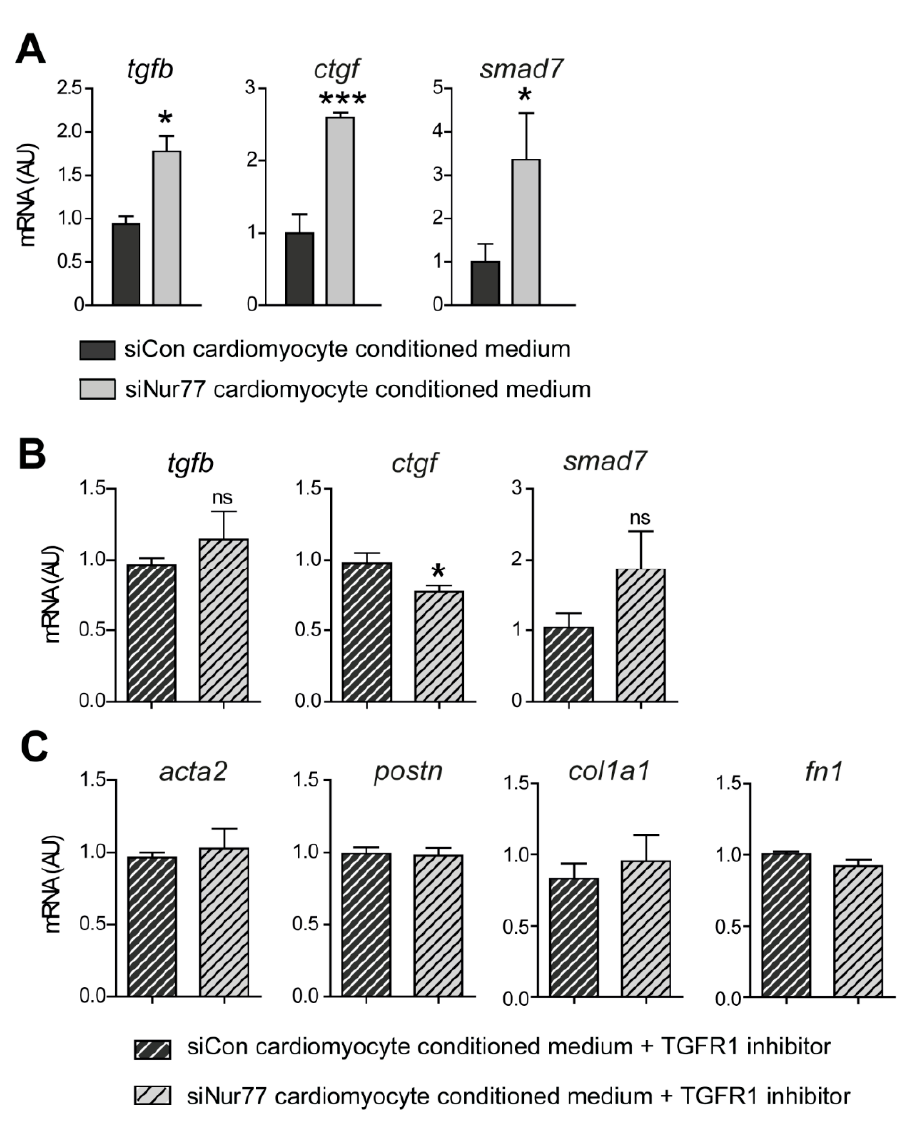
Figure 5. Nur77-silenced cardiomyocytes promote a MyoFB phenotype in CF via TGF- β . ( A ) Expression of TGF- β and target genes in CF stimulated with conditioned medium from siCon or siNur77 neonatal rat cardiomyocytes, as assessed by qPCR. ( B ) Expression of TGF- β target genes and MyoFB genes ( C ) in CFs stimulated with conditioned medium from siCon or siNur77 neonatal rat cardiomyocytes after 15 min pre-incubation with 10 µ M TGF- β receptor I (TGFR1) inhibitor SB431542. Conditioned medium stimulation (1:2 ratio with fresh medium) was for 24 h. tgfb : transforming growth factor— β , ctgf : connective tissue growth factor. Data presented as mean + SEM; * p < 0.05, *** p < 0.001 vs. siCon same stimulus, ns—not significant.